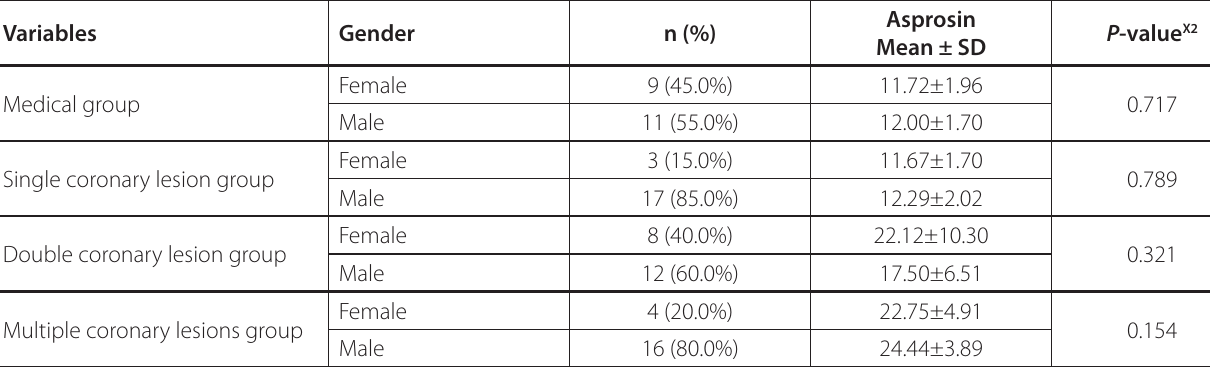
Table 4 . Asprosin values by gender.